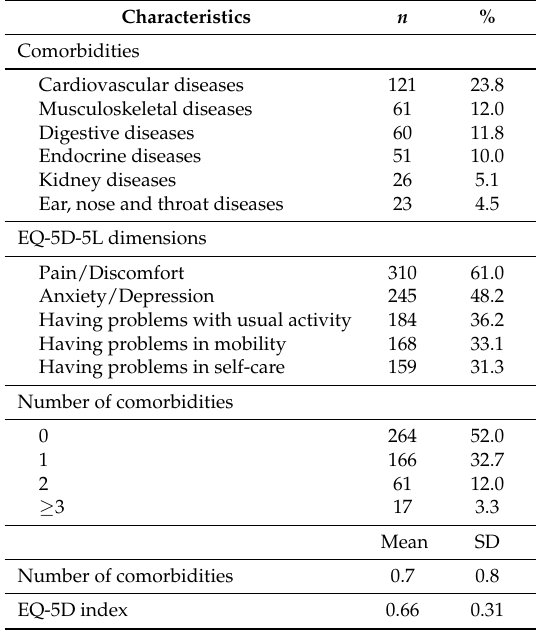
Table 2. Health-related quality of life (HRQOL) and comorbidities among